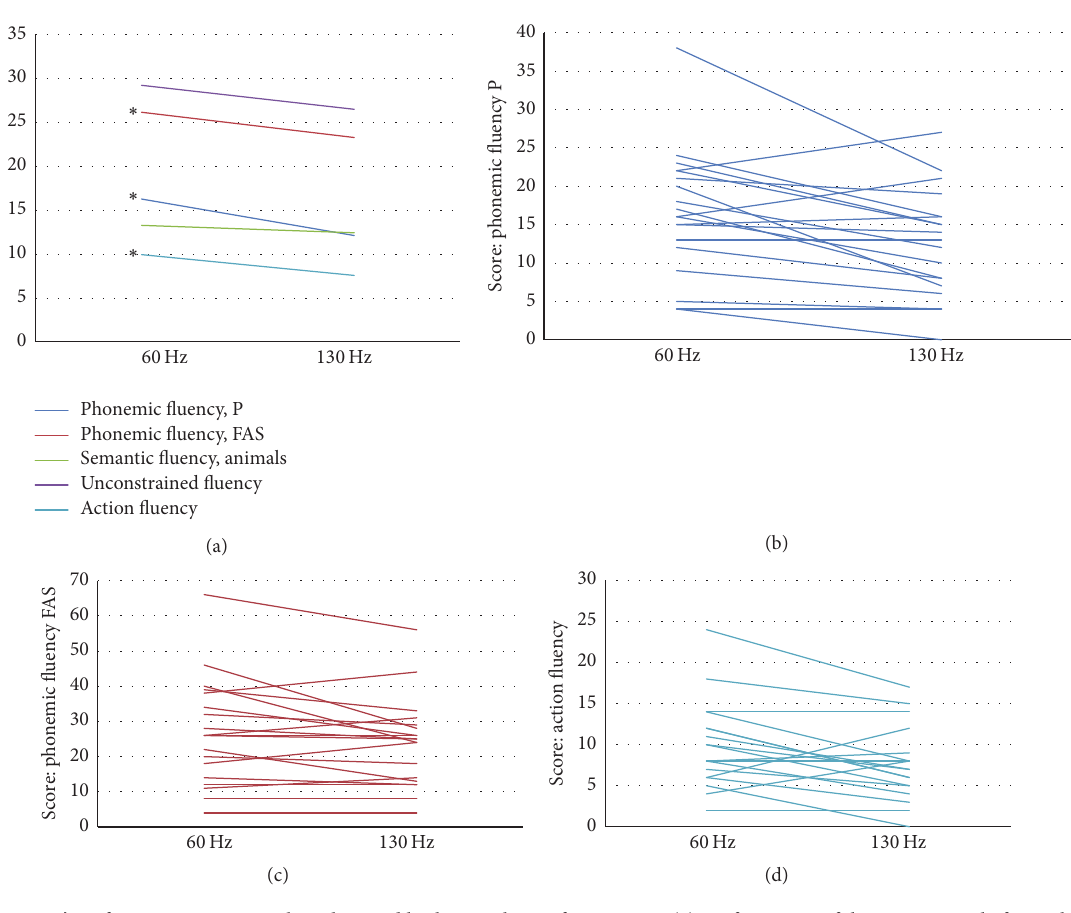
Figure 1: Patients’ performances on VF tasks at low and high stimulation frequencies. (a) Performance of the entire sample for each VF task. ∗ denotes the significant difference between frequency conditions for the respective task. (b) Phonemic fluency performance (P version) by the patient. (c) Phonemic fluency performance (FAS version) by the patient. (d) Action fluency performance by the patient.